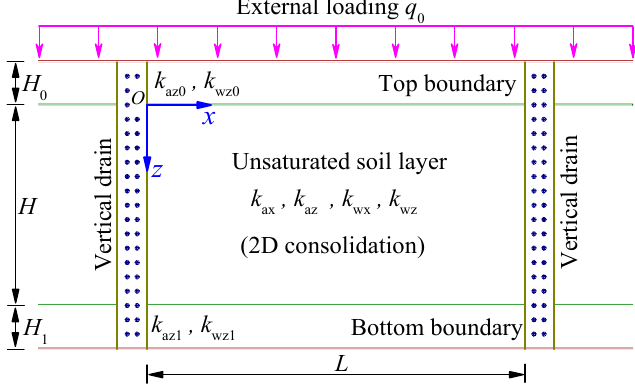
Figure 1. Two-dimensional (2D) consolidation system of unsaturated soil with vertical impeded drainage boundaries.